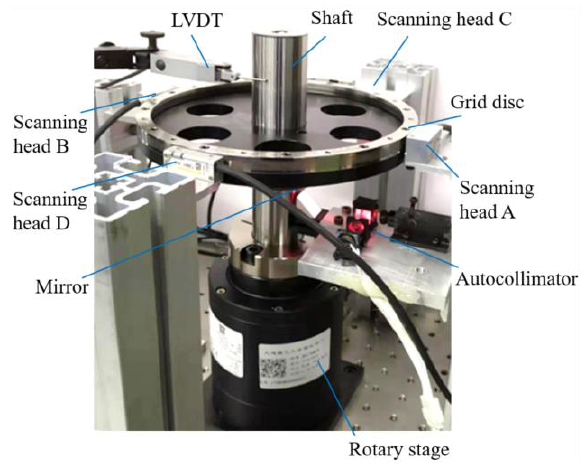
Figure 6. Experimental setup.